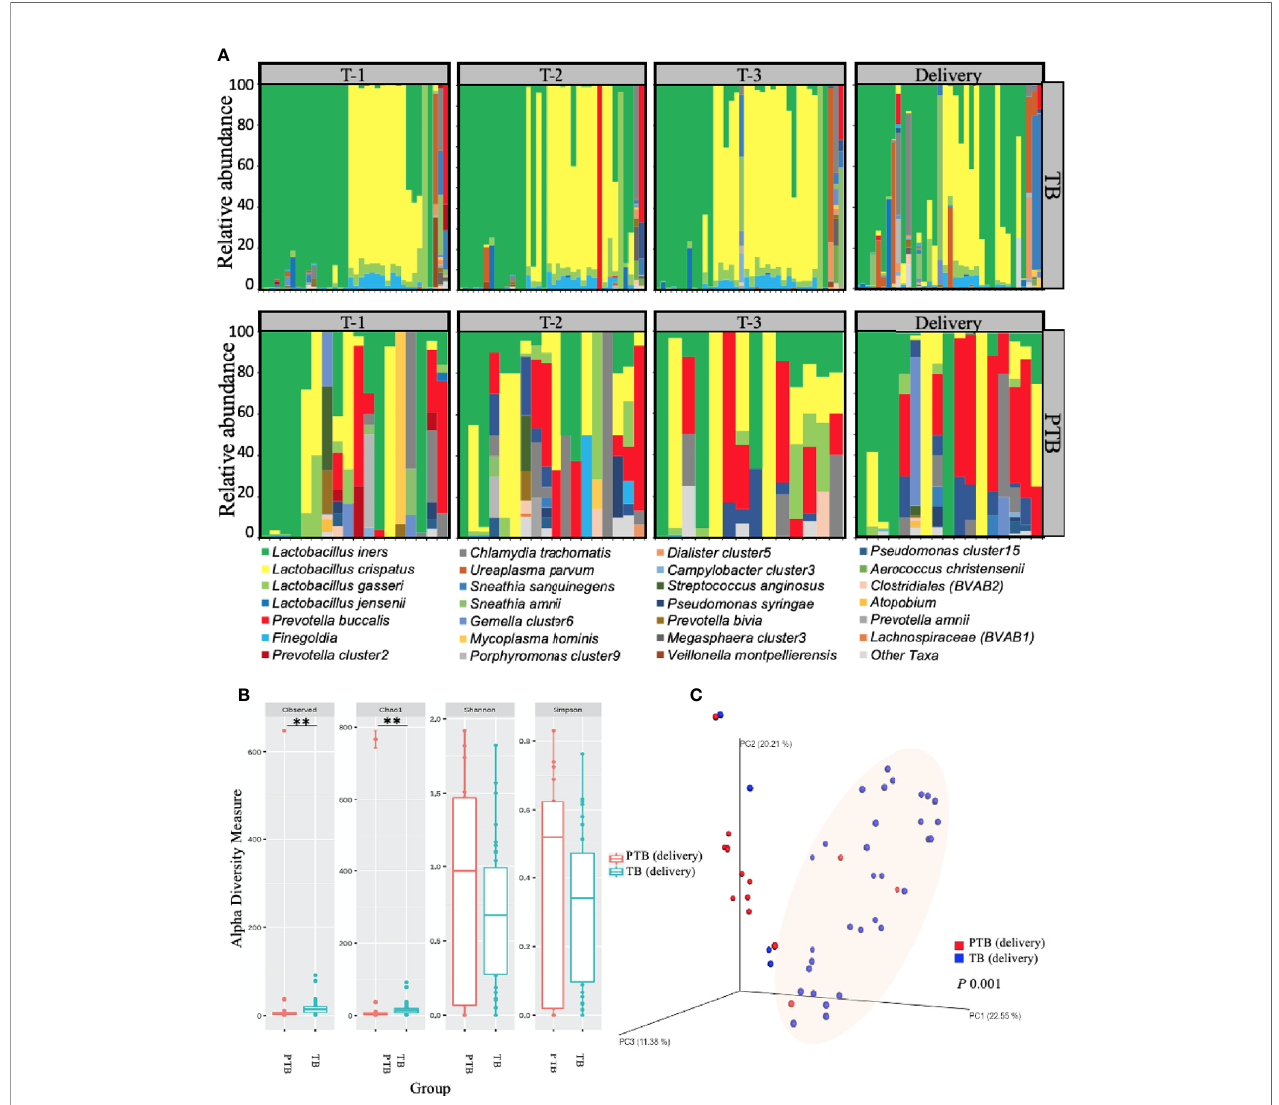
FIGURE 3 | Vaginal microbiome composition in women with TB and PTB. (A) Stacked bar plots showing the relative abundance (%) of each microbial species in vaginal swabs from women who had full term birth (TB) and women who experienced preterm birth (PTB). Each vertical bar represents one woman. (B) Alpha diversity of the microbiome at delivery was compared between the two groups by the number of operational taxonomic units (OTUs) observed and by the Chao1, Shannon and Simpson diversity indices. The asterisks indicate a signi fi cant difference in diversity of microbial communities between the two groups (**P < 0.01). (C) Beta diversity plot showing microbial communities clustered using Principle Coordinates Analysis (PCoA) based on Bray – Curtis dissimilarities between vaginal microbiomes. Statistical signi fi cance of the alpha diversity measures was calculated using the Kruskal-Wallis test for non-parametric data, while analysis of similarities method (ANOSIM) was used for calculation of the distance matrix difference between the TB and PTB groups using unweighted beta diversity parameters. P-values lower than 0.05 were considered statistically signi fi